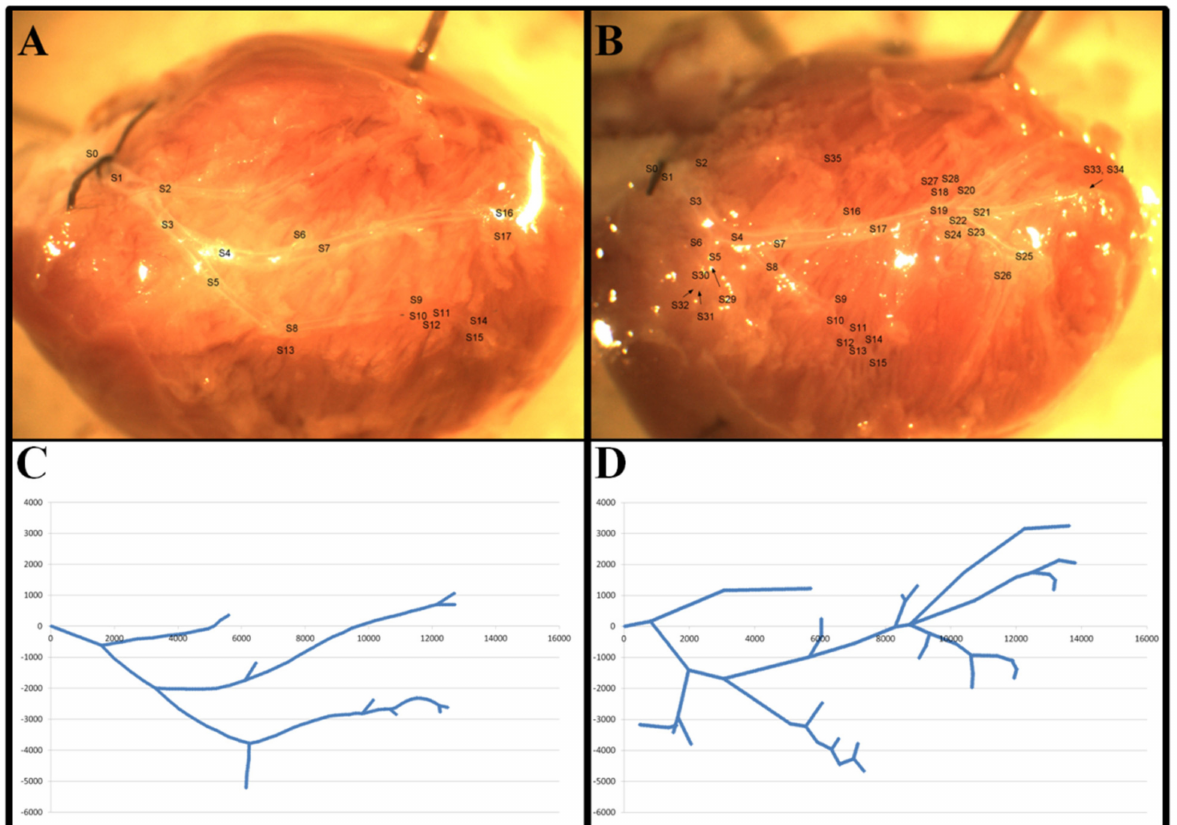
Figure 1. Representative video-microscopic images of segmental and branching analysis ( A , B ) and mapping of the LAD networks in a coordinate system, following 50 µ m-ring-unit analysis ( C , D ). Note the difference between the two experimental groups in the network density of the LAD coronary artery, shown in the image and the associated coordinate system of a typical vitamin-D-deficient ( A , C ) and a typical vitamin-D-supplemented animal ( B , D